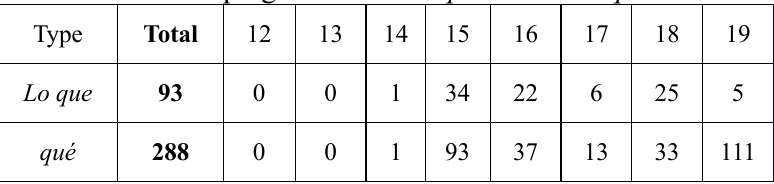
vs. qué + V fin fin